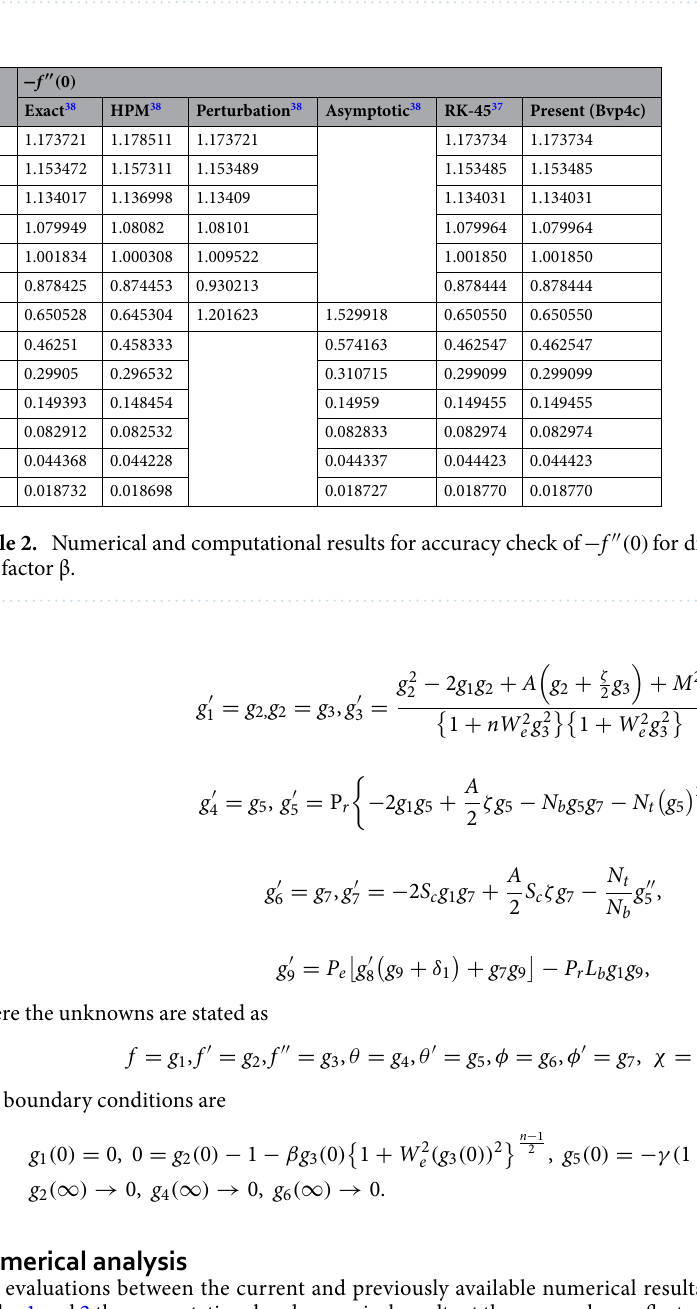
f ′′ ( 0 ) for different values of the magnetic factor M 2 . −